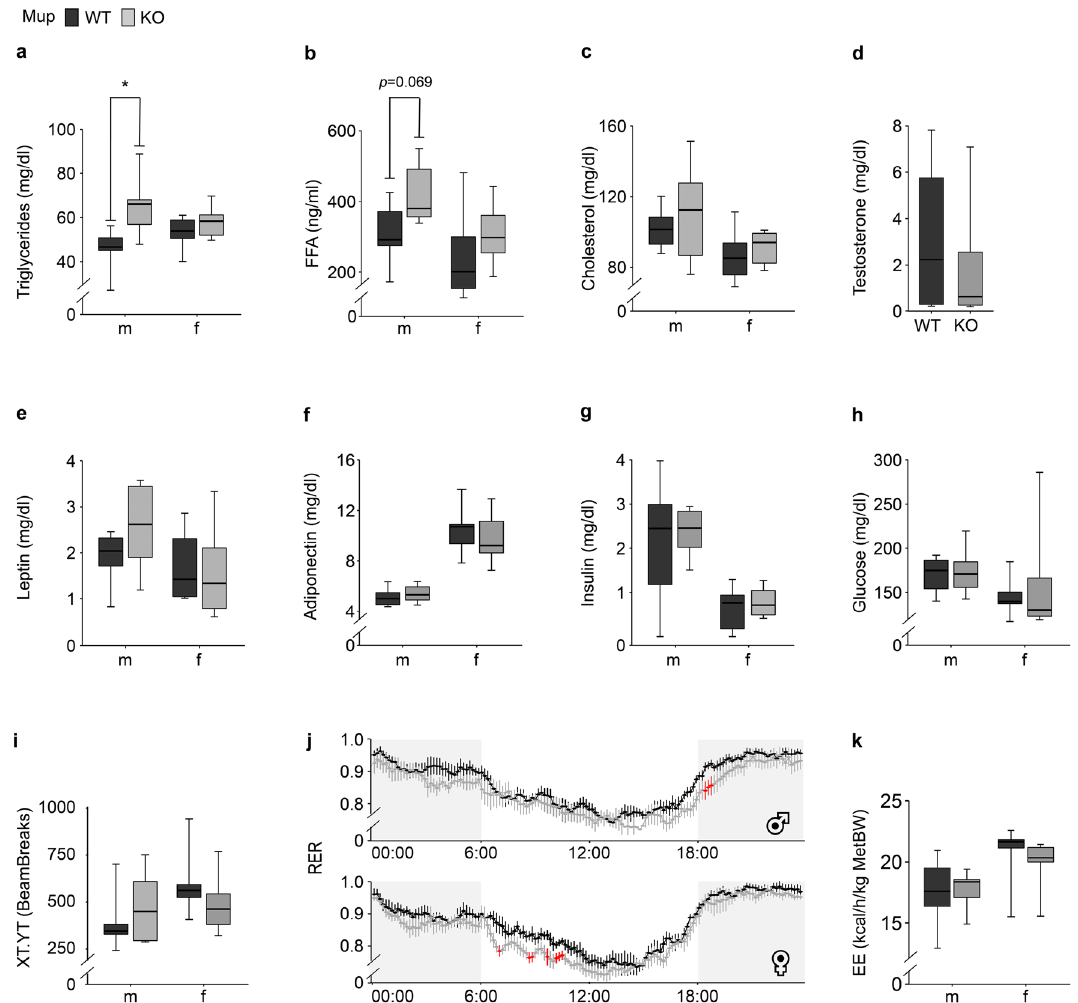
Figure 3. Metabolic characterization of twelve-week-old male (m) and female (f) Mup knockout (KO) mice (grey) and Mup wildtype (WT) mice (black). ( a – c ) Plasma concentrations of lipid metabolic biomarkers: ( a ) triglycerides, ( b ) free fatty acids (FFA) and ( c ) cholesterol. ( d ) Plasma testosterone concentration of mWT and mKO mice. ( e , f ) Plasma concentrations of lipid metabolism related hormones: ( e ) leptin, ( f ) adiponectin. ( g , h ) Plasma concentration of glucose metabolic biomarkers: ( g ) insulin, ( h ) glucose ( a , c – h : n = 6; b : mWT = 6, mKO = 5, fWT = 6, fKO = 4). ( i ) Mean total 48 h activity (mWT = 6, mKO = 5, fWT = 6, fKO = 6) detected via infrared light beam breaks. ( j ) Mean circadian respiratory exchange ratio (RER) per sex according to genotype monitored over 48 h in the Phenomaster (mWT = 6, mKO = 5, fWT = 6, fKO = 6). Light (white) and dark phase (grey) is indicated. Data was adjusted to metabolic BW (lean mass + 0.2 × fat mass). Results of two-tailed t-test at specific time point: p < 0.05 (red). ( k ) Mean hourly energy expenditure (EE) per group (mWT = 6, mKO = 5, fWT = 6, fKO = 6) monitored over a period of 48 h and normalized to the metabolic BW (MetBW). Data ( a – i , k ) are presented as Spear style boxplots, where the whiskers indicate the minimum and maximum value, lower and upper hinges correspond to the upper and lower quartiles, and center line to the median. Results of ( j ) are presented as mean ± SEM. In ( j ) a linear model additionally accounting for repeated measurements was applied to calculate the KO effect. P -values of the two-tailed t-test < 0.10 are indicated. * p < 0.05 in two-tailed